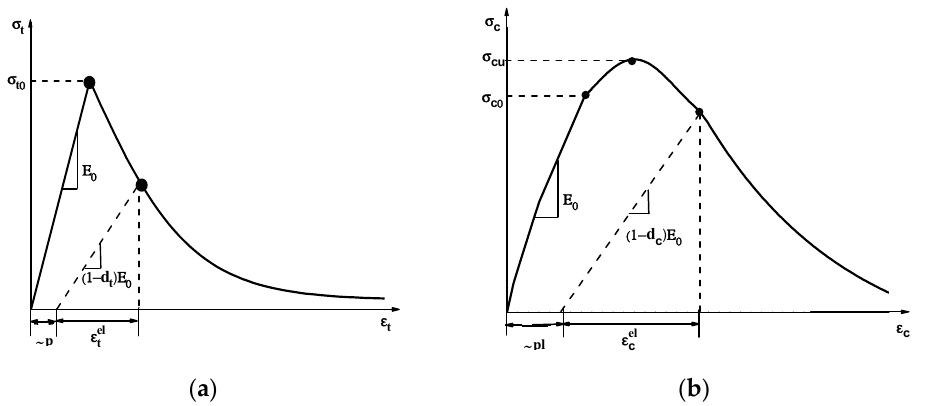
Figure 9. Constitutive curves for uniaxial damage in: ( a ) tension; ( b ) compression. Figure 8. Initial modeling for FEM analysis: ( a ) screw; ( b ) helical blade. Similar to Equation (5), the tension damage, d t , depends on (cid:101) ε pl Equation (6) [34]. Tension Normal density ( 0.35g/cm 3 )